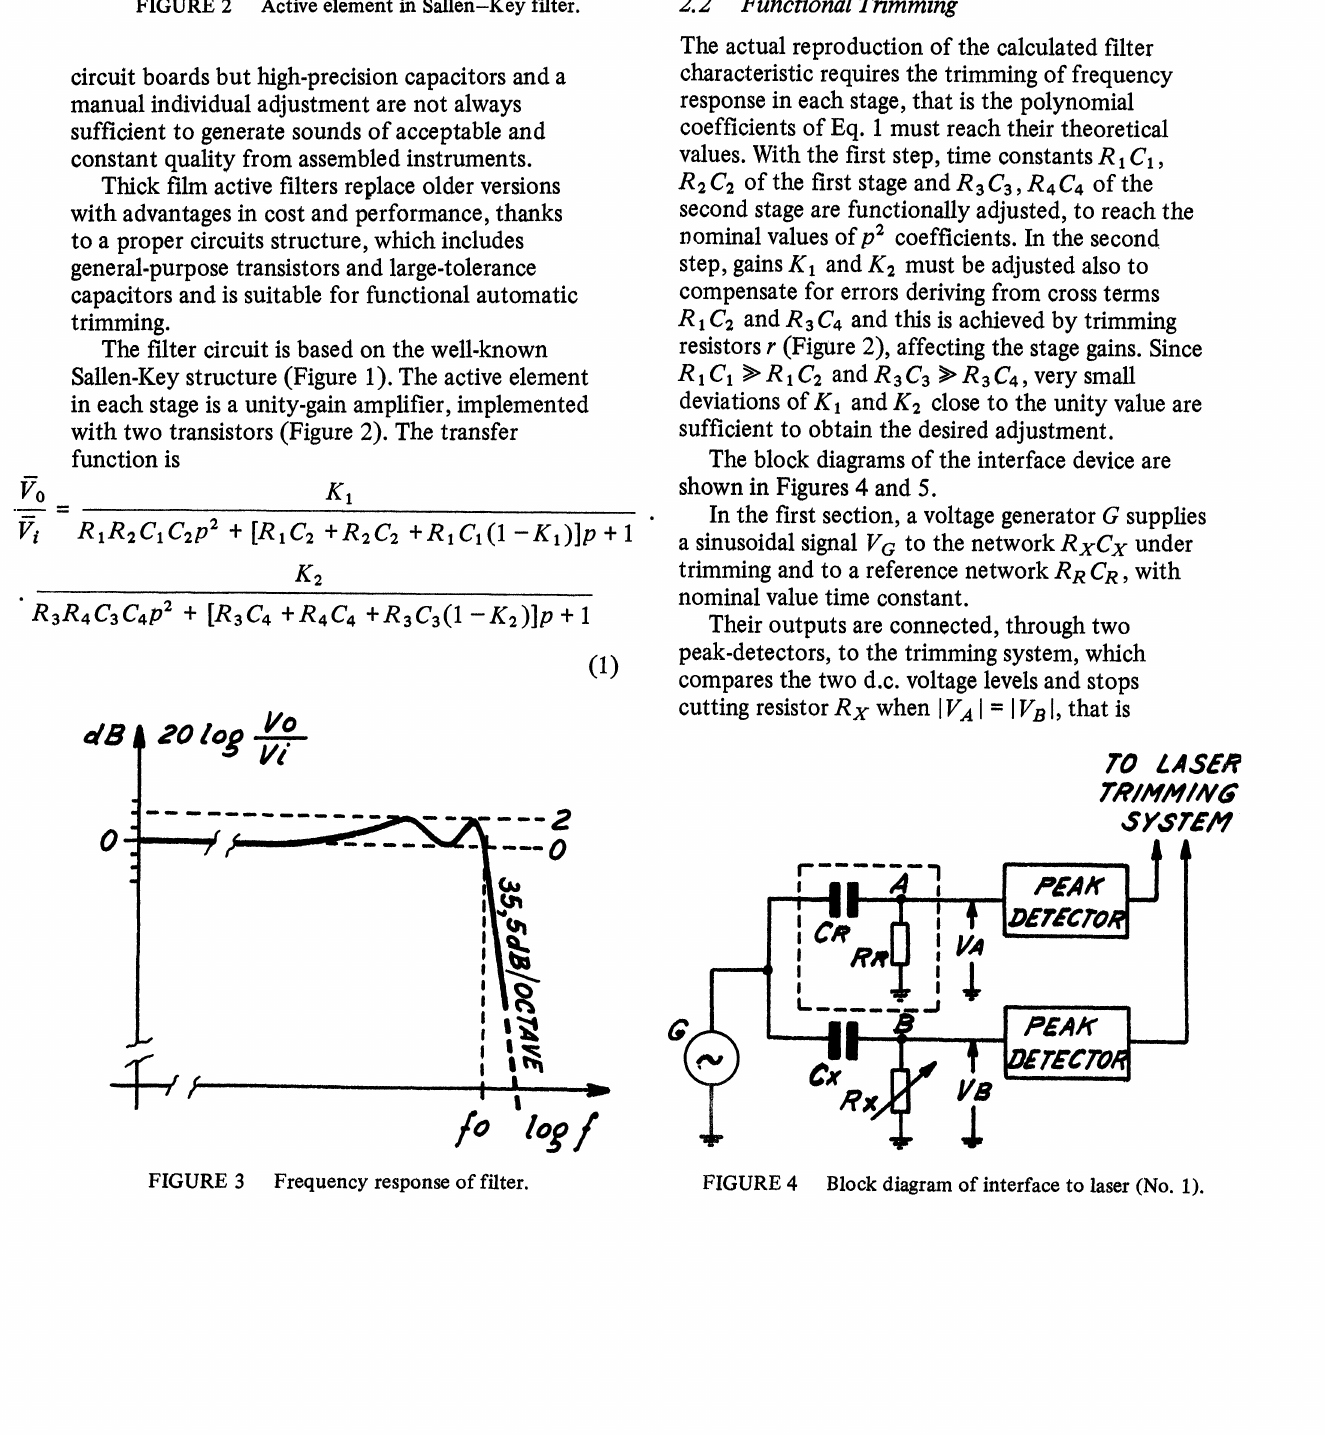
FIGURE 2 Active element in Sallen-Key filter.